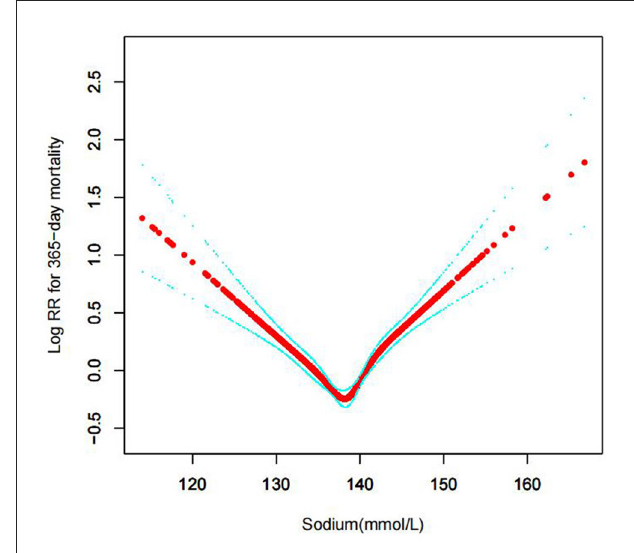
FIGURE3 Association between serum sodium levels and 30-day all-cause mortality (Unadjusted model).